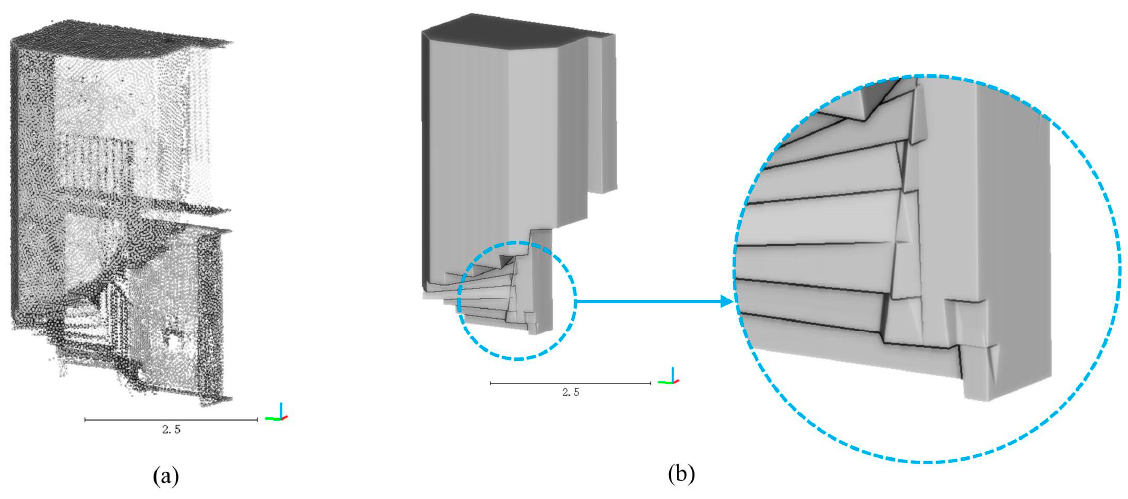
Figure 12. ( a ) Original point cloud; ( b ) reconstructed room layout of cross-floor space, where too many small pieces of subspaces result in defects in the result model.